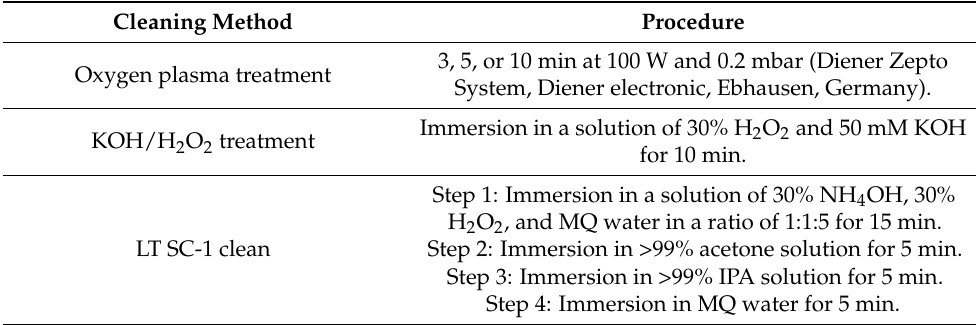
Table 1. Cleaning procedures used in the study. Cleaning Method